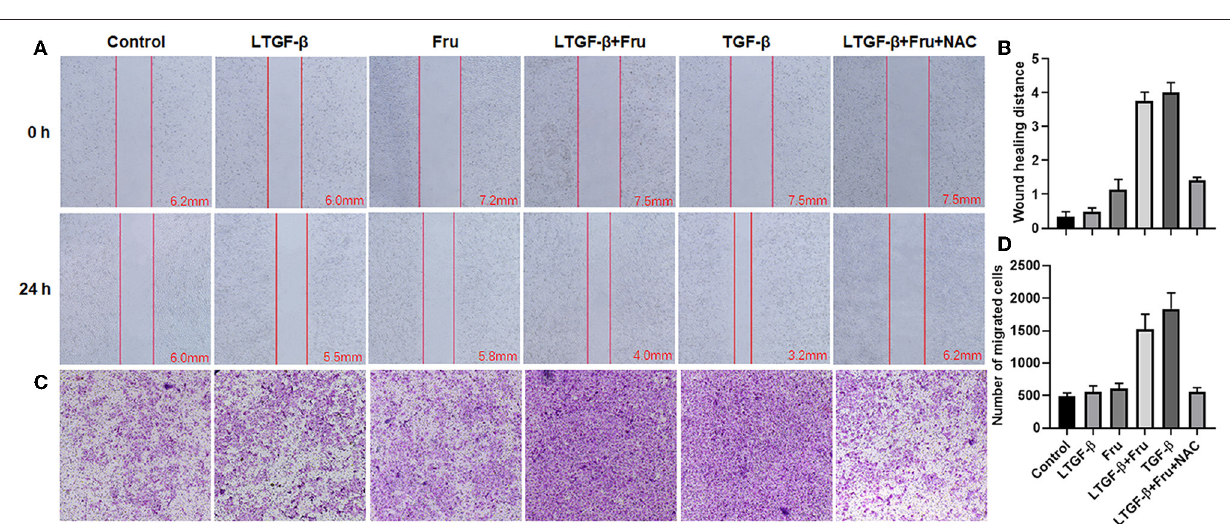
FIGURE 10 | Effect of fructose on latent TGF- β 1-induced A549 cell migration and invasion. (A) Wound healing assays of A549 cells, the wound closure was photographed at 24 post-scratching (40 × magnification). (B) Wound healing distance = (the initialized width of the scratch) – (the final width). (C,D) Invasion Chambers (40 × magnification) and counts of cells under the microscope. Control, 0mM fructose; Fru, 10mM fructose; LTGF- β 1, latent TGF- β 1; LTGF- β 1 + Fru, latent TGF- β 1 + 10mM fructose; LTGF- β 1 + Fru + NAC, latent TGF- β 1 + 10mM fructose +